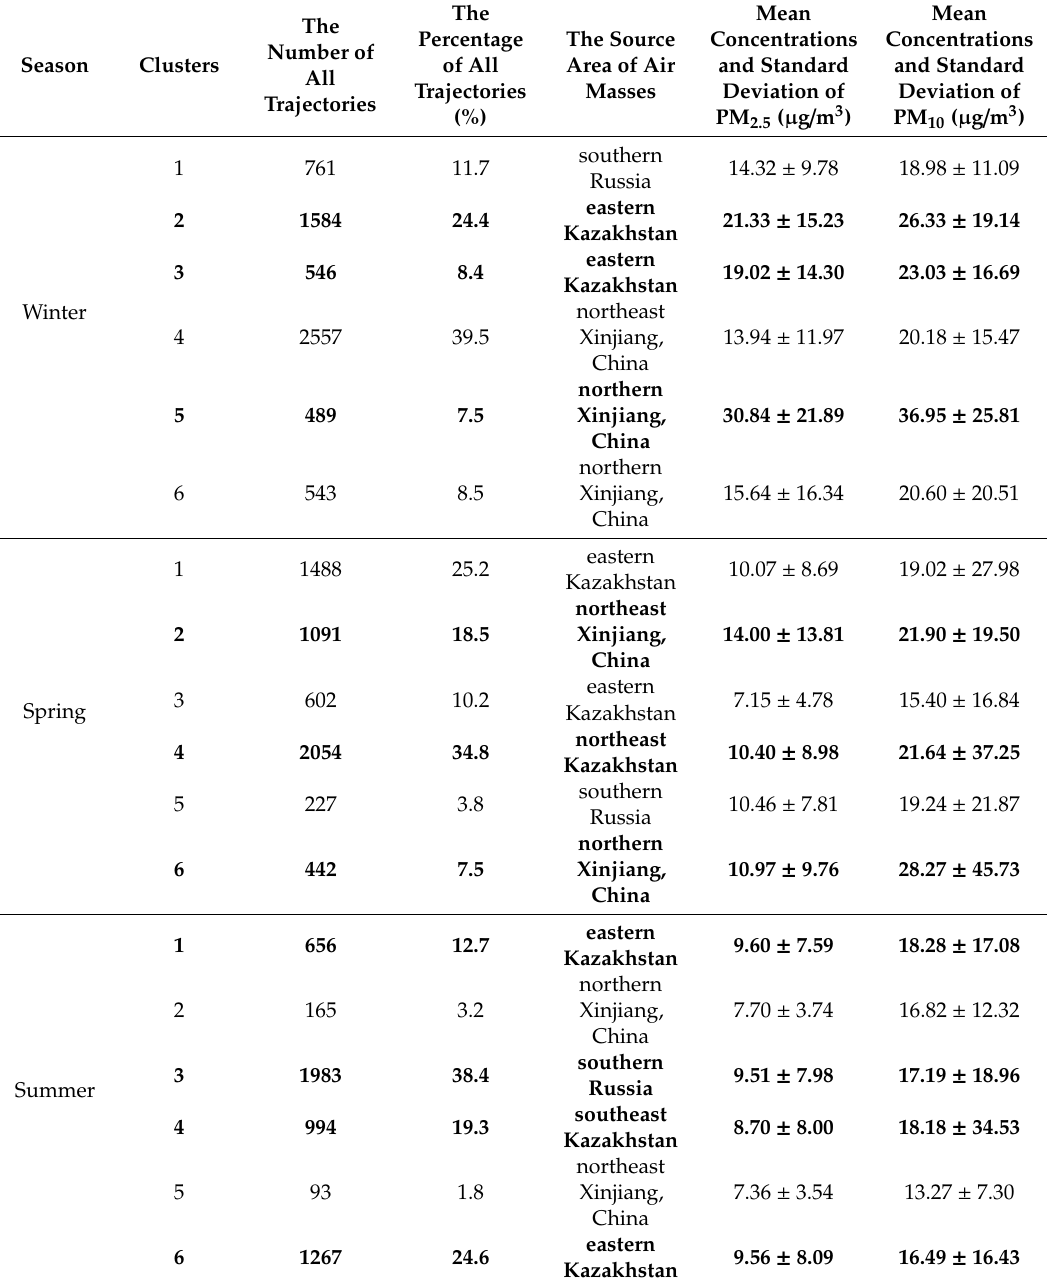
Table 3. Trajectory numbers and mean concentrations and standard deviations of PM based on all trajectories (bold values represent the polluted